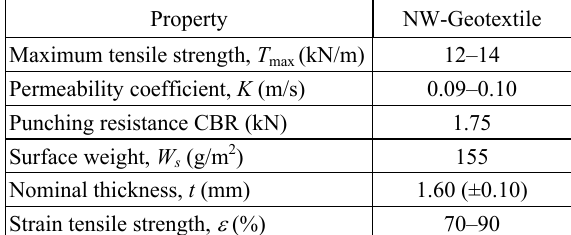
Table 2. Physical and mechanical properties of geotextile used in the study